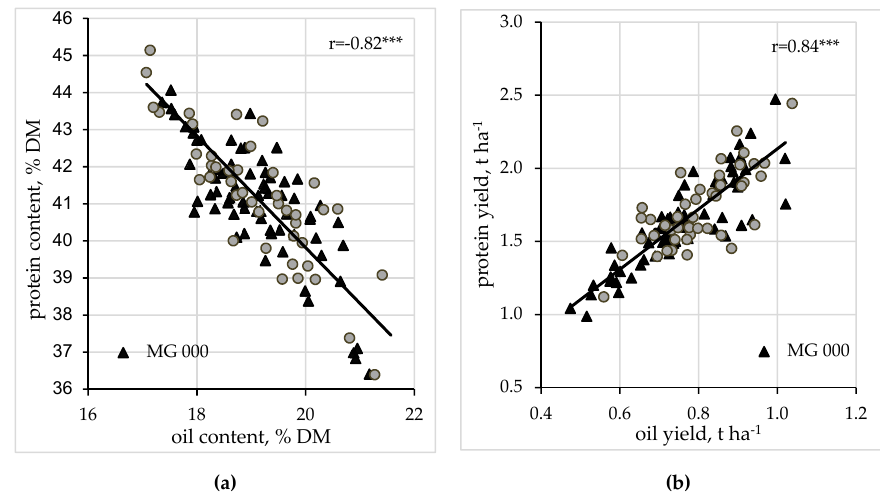
Figure 1. Correlation between protein content and oil content ( a ) and protein yield and oil yield ( b ) of soybean. Figure shows results from five locations, 13 varieties from the maturity groups MG 00 and MG 000; two trial years (2016, 2017). *** p < 0.001.